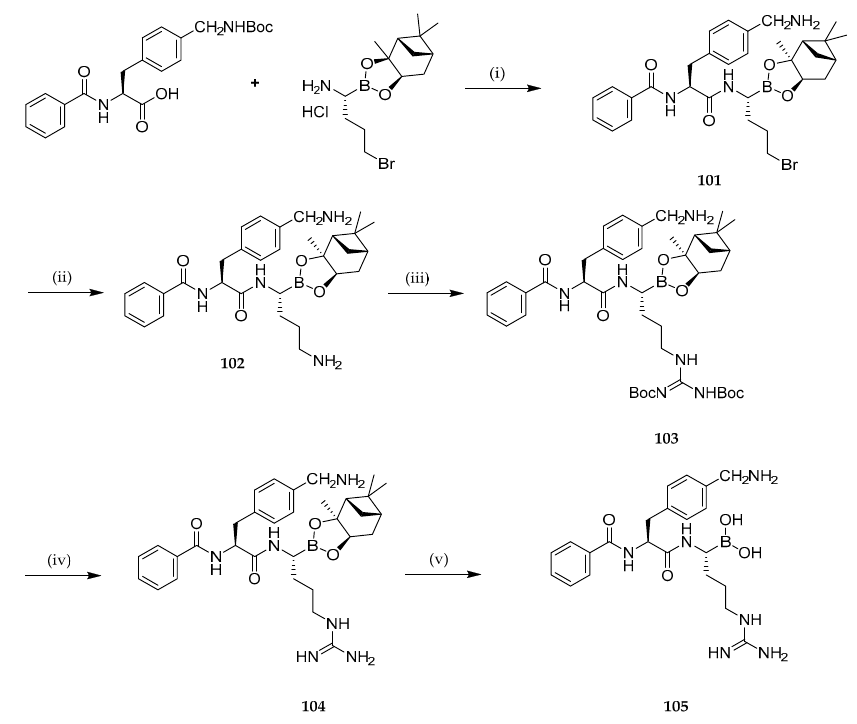
Table 7. Inhibitory activity (K i , μ M) of compound 105 in different flaviviral